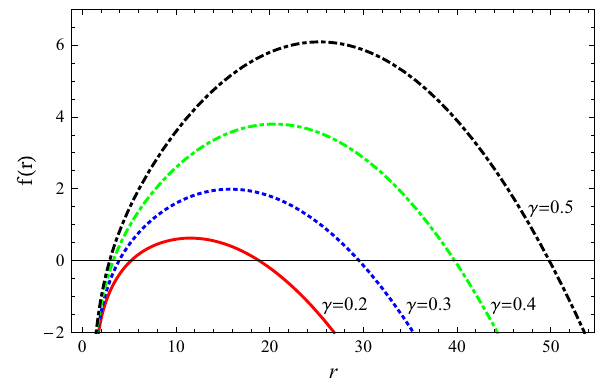
Fig. 1 The behaviour of metric function f ( r ) plotted against radial coordinate r for varying γ with α 2 m = − 0 . 01 , M = 1 ,α g = 1 ,(cid:14) = 0